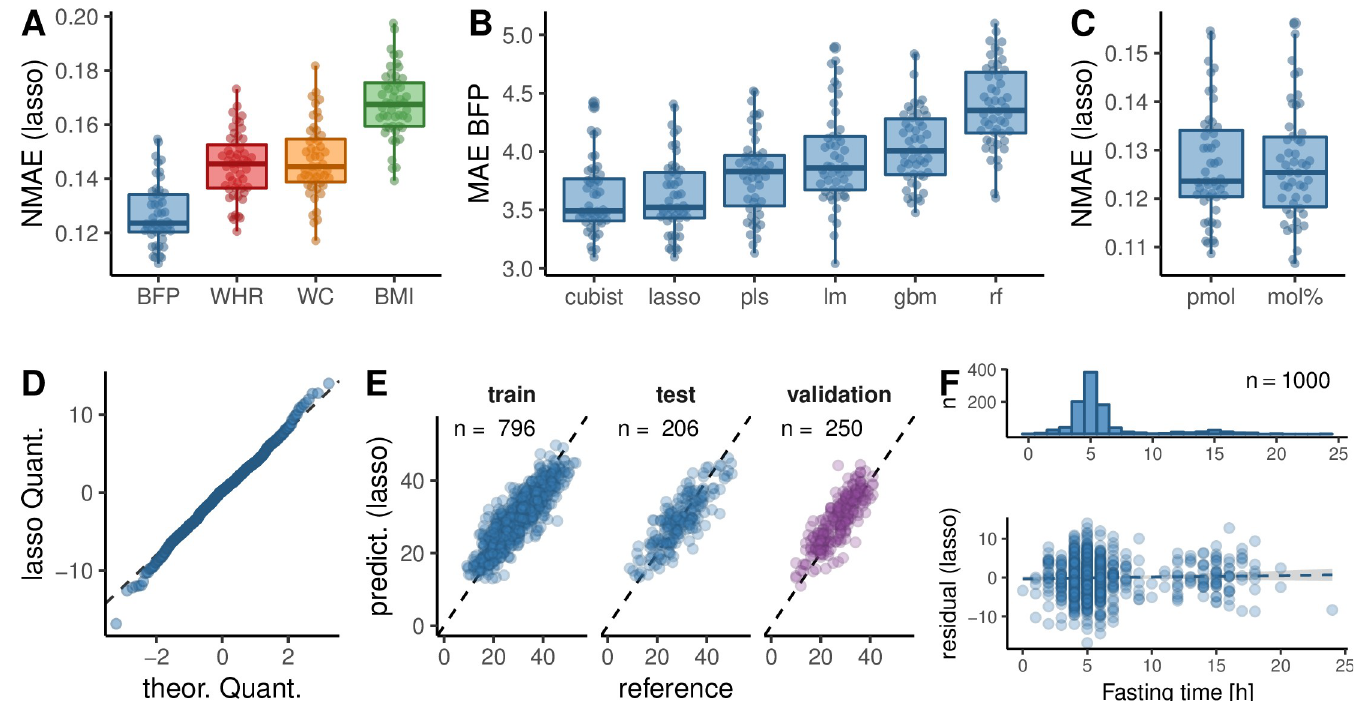
Fig 1. Regression of obesity measures by lipidome, age, and sex. (A) The NMAE (MAE divided by the range from the 5th to 95th percentile; S2 Fig) of different obesity measures based on Lasso regression of molar amount data. Only subjects were used, for which all obesity measures were available. (B) MAE of BFP comparing different regression algorithms on molar lipid amount data (S7 Table). (C) Lasso based NMAE of BFP comparing direct molar amounts (pmol) to molar amounts standardized to the total lipid amount within a sample (mol%). A two-sided, unpaired Mann–Whitney U test resulted in a p -value of 0.99. (A–C) The summary statistics of a 5 × repeated 10-fold cross validation of the FINRISK training data set (80% of the data set) are shown. (D) Quantile-quantile plot of the training residuals of the Lasso BFP model against a normal distribution. (E) Original BFP values (reference) in the FINRISK training, test, and the MDC-CC validation data set plotted against the prediction of Lasso regression based FINRISK training set. n signifies the number of samples in each set. (F) Histogram of fasting times of subjects in the FINRISK data set and scatter plot of the Lasso residuals against fasting time, including a linear model. The slope of the linear model had a p -value of 0.33. BFP, body fat percentage; BMI, body mass index; gbm, stochastic gradient boosting; lm, linear model; MAE, mean absolute error; MDC-CC, Malmo¨ Diet and Cancer Cardiovascular Cohort; mol%, molar fraction; NMAE, normalized MAE; pls, partial least squares; pmol, picomol; rf, random forest; WC, waist circumference; WHR, waist-hip ratio.